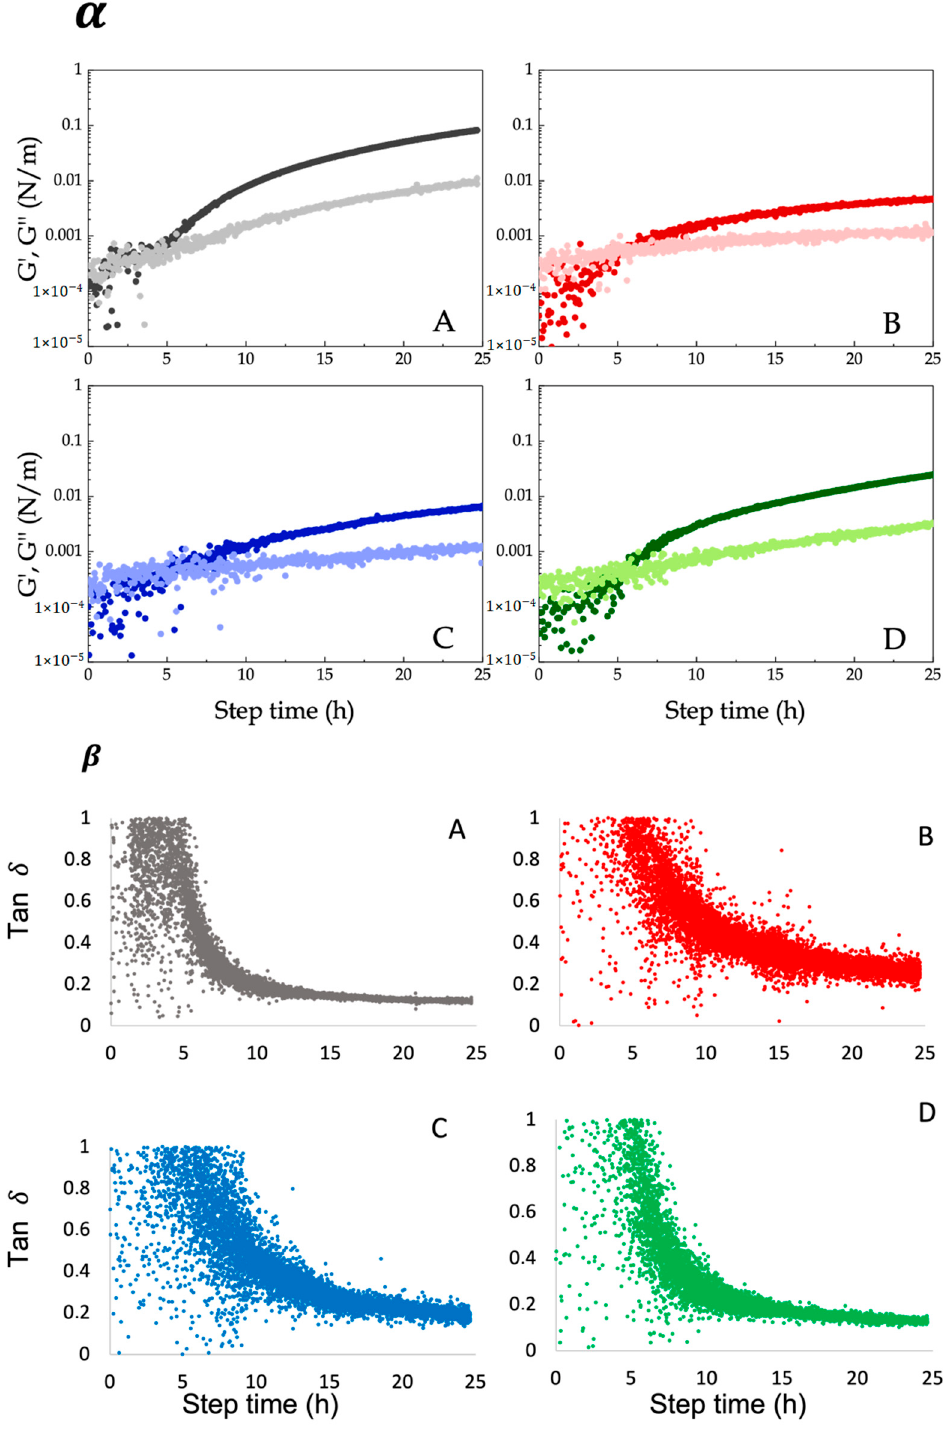
Figure 9. Time sweep for 25 h at 0.2 Hz, 0.1% strain and 20 °C. (𝜶) Storage G ′ (dark colored) and loss G” (light colored) moduli; ( β ) tangent loss tan δ of SPPH samples with 0 ( A ), 0.1 ( B ), 0.2 ( C ) and loss G ″ (light colored) moduli; (𝜷) tangent loss tan 𝛿 of SPPH samples with 0 ( A ), 0.1 ( B ), 0.2 ( C ) 0.4 ( D ) M NaCl are here and 0.4 ( D ) M NaCl are here presented.